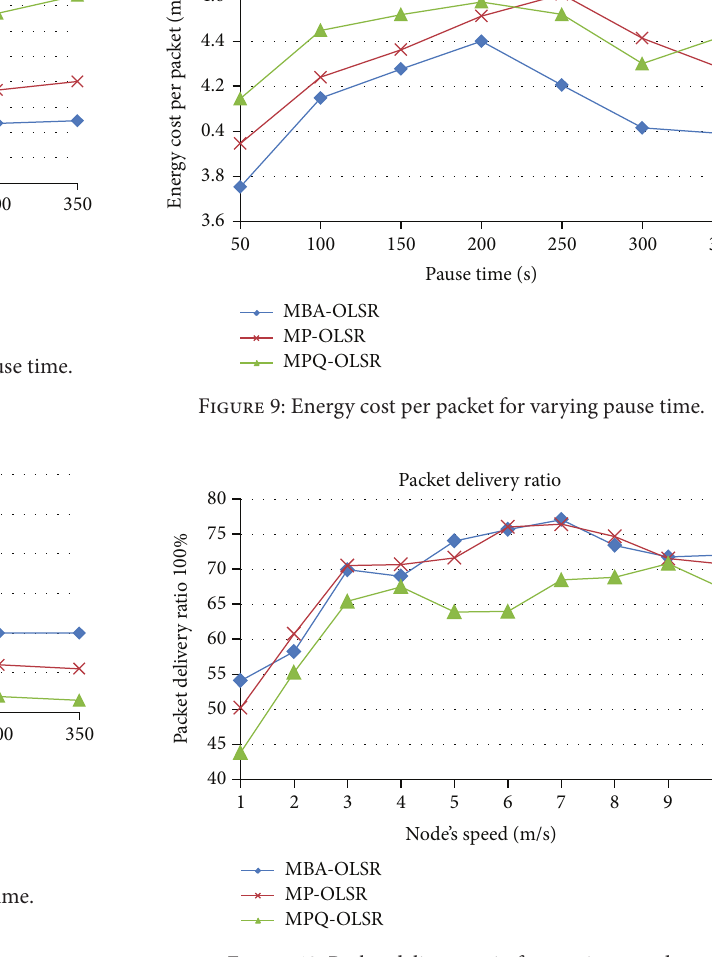
Figure 10: Packet delivery ratio for varying speed.